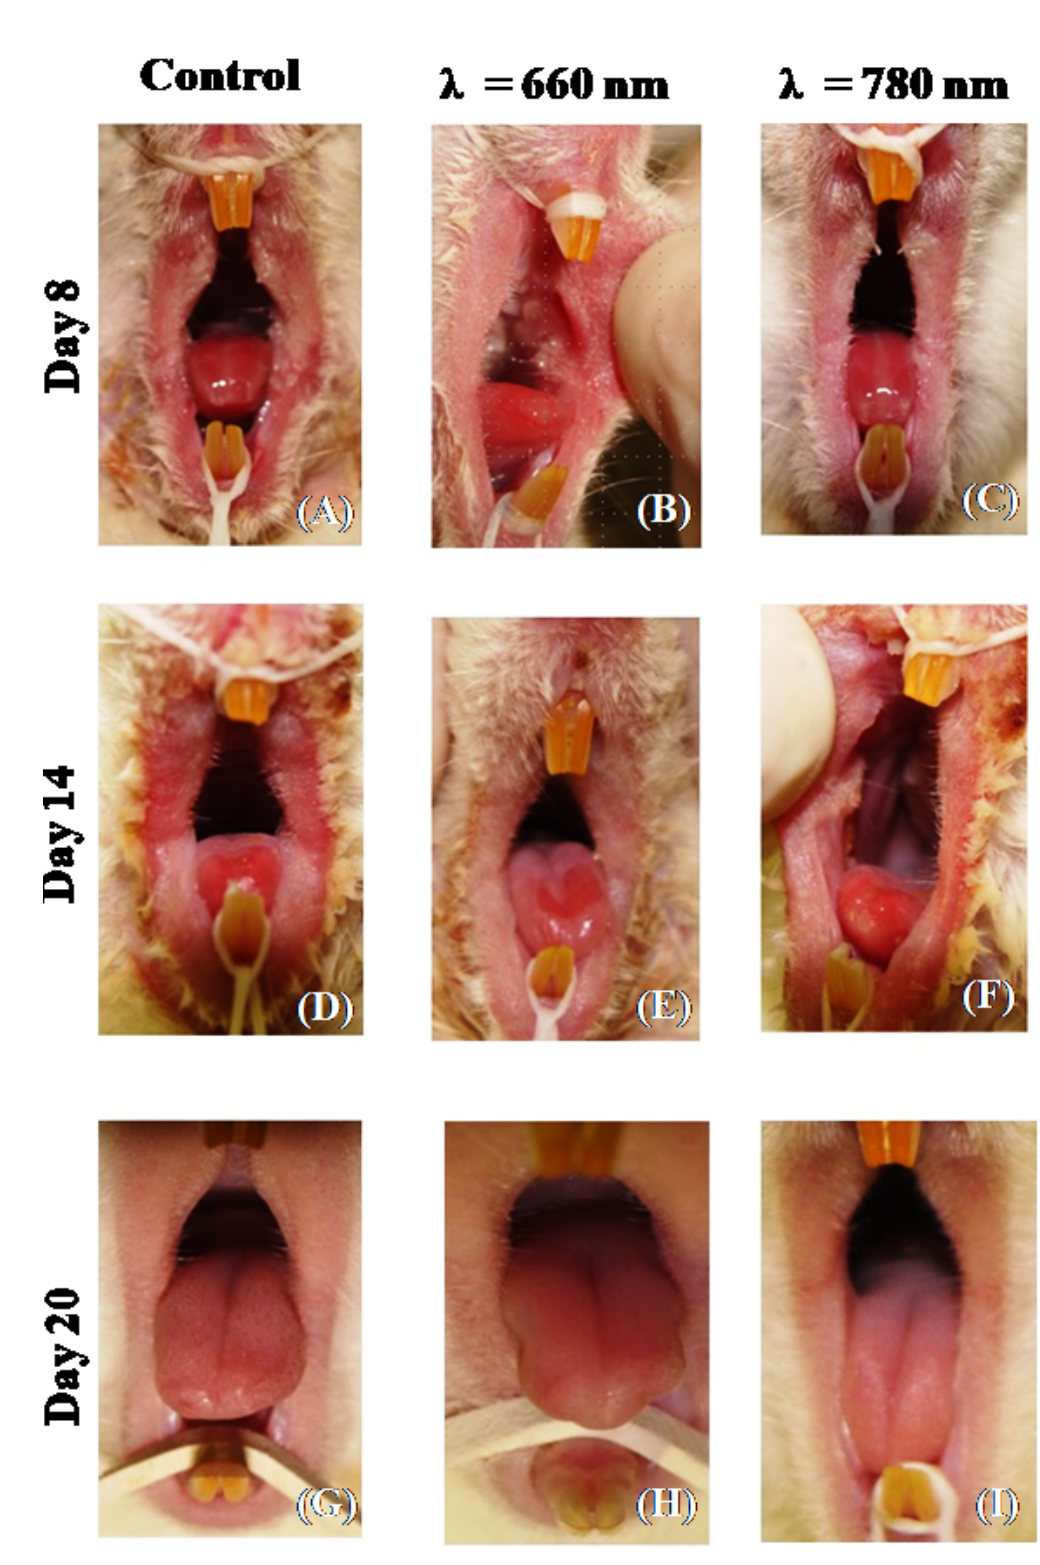
Figure 2. Representative images of the clinical aspect of the tongue after induction of oral mucositis with ionizing radiation (control group, ( A , D , G )). The tongue received photobiomodulation with λ = 660 nm (660 nm group, B, E and H) or λ = 780 nm (780 nm group, ( C , F , I )). The tongue was analyzed after 8 days ( A – C ), 14 days ( D – F ), and 20 days ( G – I ) of ionizing radiation.